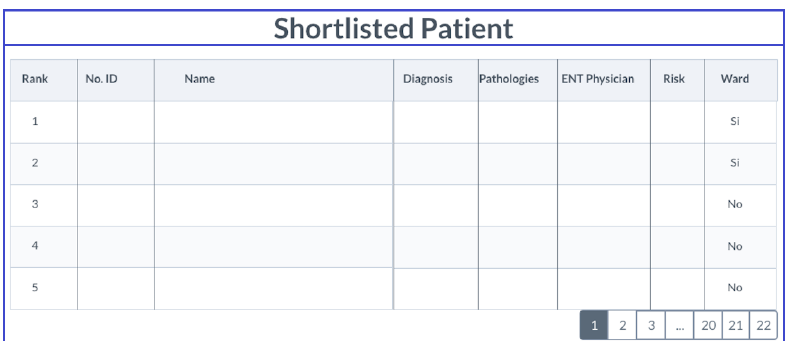
Figure 10. In this Figure, the health team can see the list of shortlisted patients and decide who will go to the ward